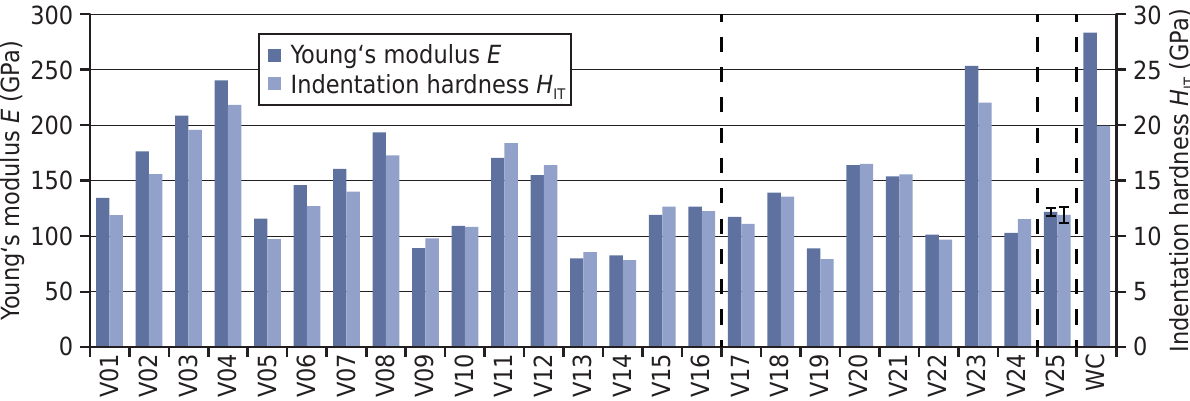
of the a-C:H:W variants and IT